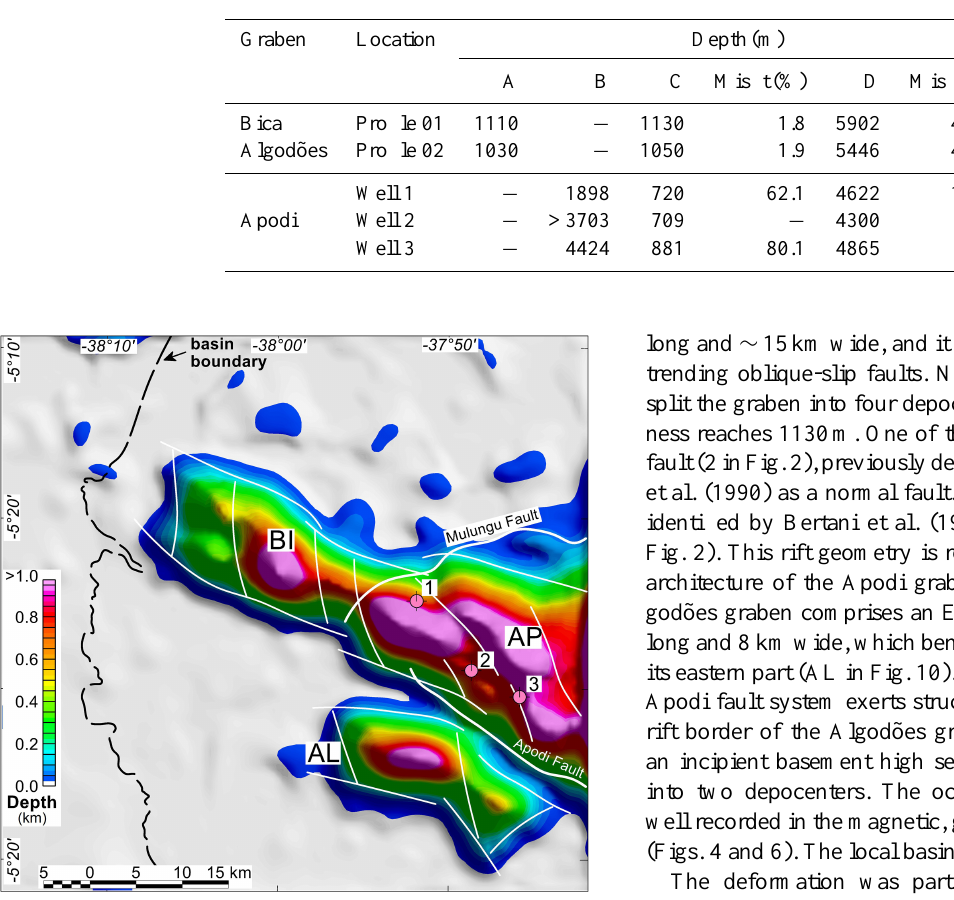
Figure 10. Basement contour map of the SW border of the Potiguar rift derived from 3-D-gravity modeling with major fault segments (thin white traces). Thick white traces: rift limits from previous studies. Grabens: BI – Bica; AP – Apodi; and AL – Algodões.